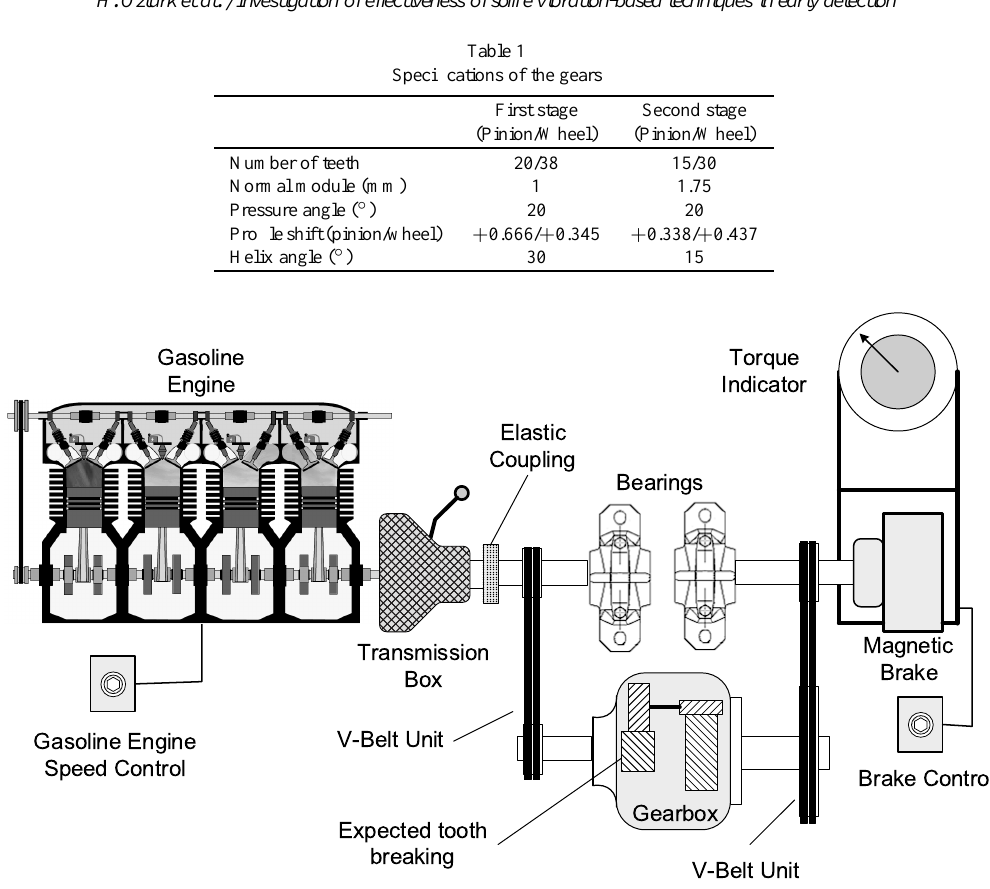
Fig. 2. Schematic representation of the test rig used for the real-time gear fatigue